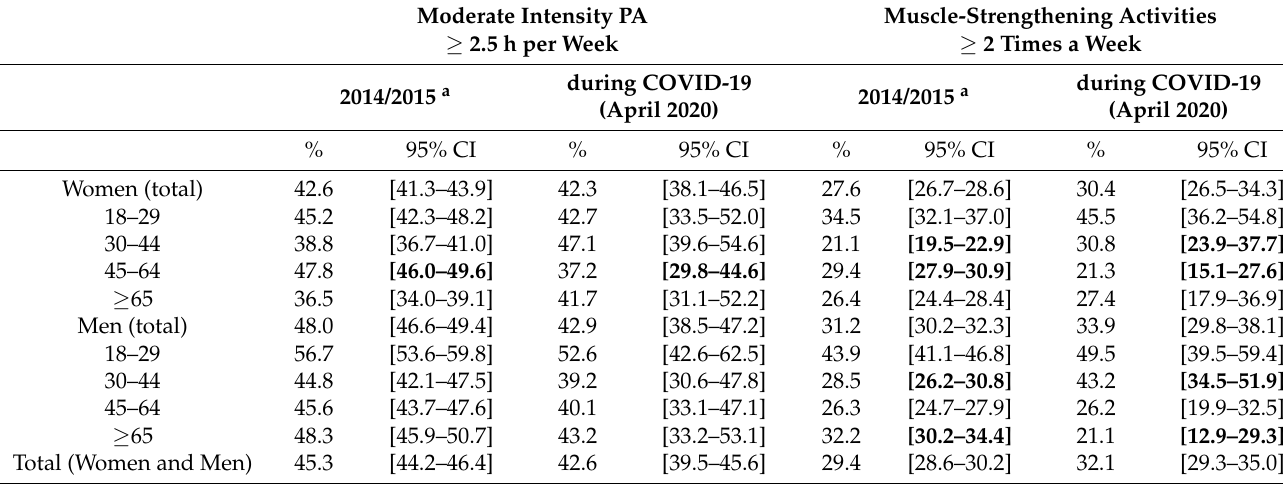
Table A1. Comparison of physical activity with reference values from the German Health Update